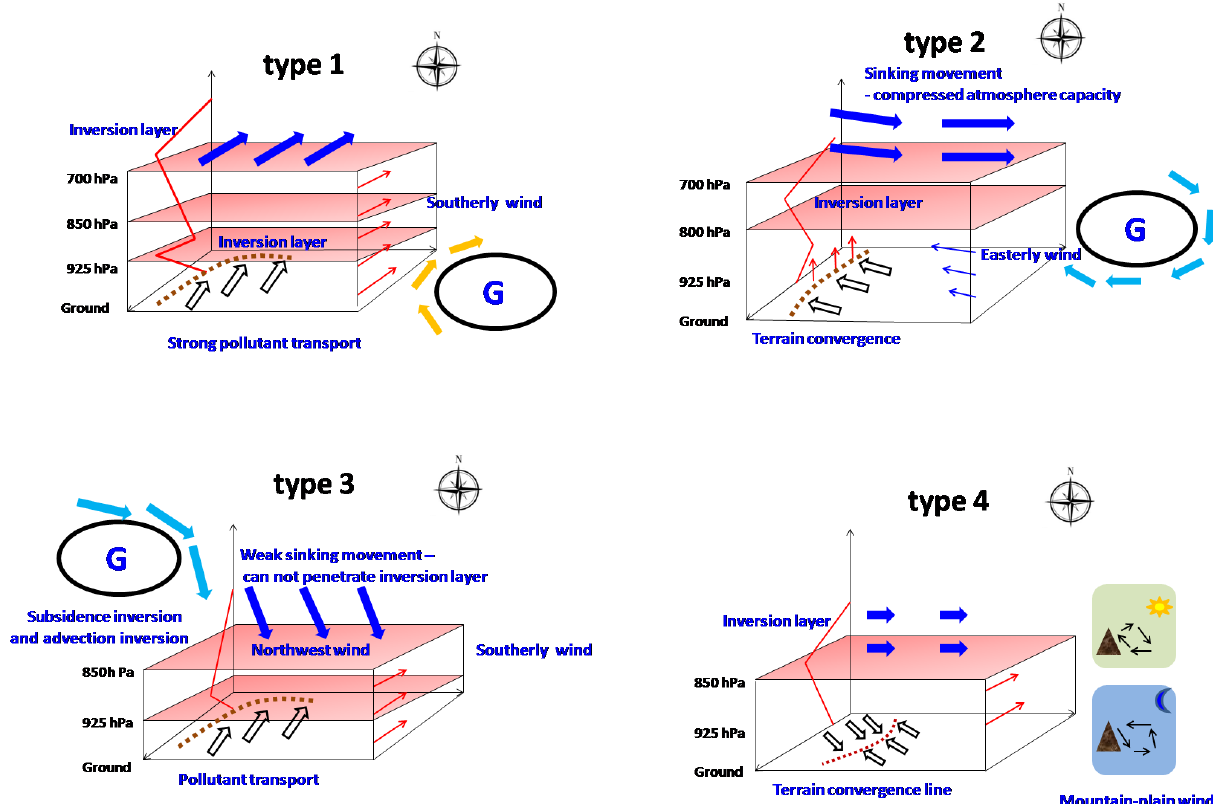
Figure 7. A thermodynamic and dynamic structure conceptual model of the pollution boundary layer for the four types of weather in the Beijing area. Arrows represent wind directions at different heights. Hollow arrows represent the ground horizontal wind field, thin red and blue arrows represent wind fields at different heights, and thick blue arrow represents the upper wind field. The dark red dots represent ground convergence lines, including (1) convergence between wind fields and (2) convergence between wind fields and topography. The solid red line is temperature. The Beijing area is located within the lowest rectangle, and the small figure in type 4 represents mountain–plain winds with a daily